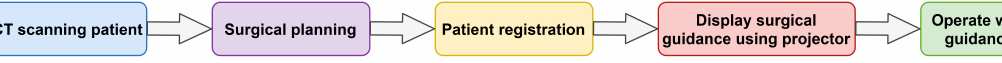
Figure 2. AR guided workflow for the